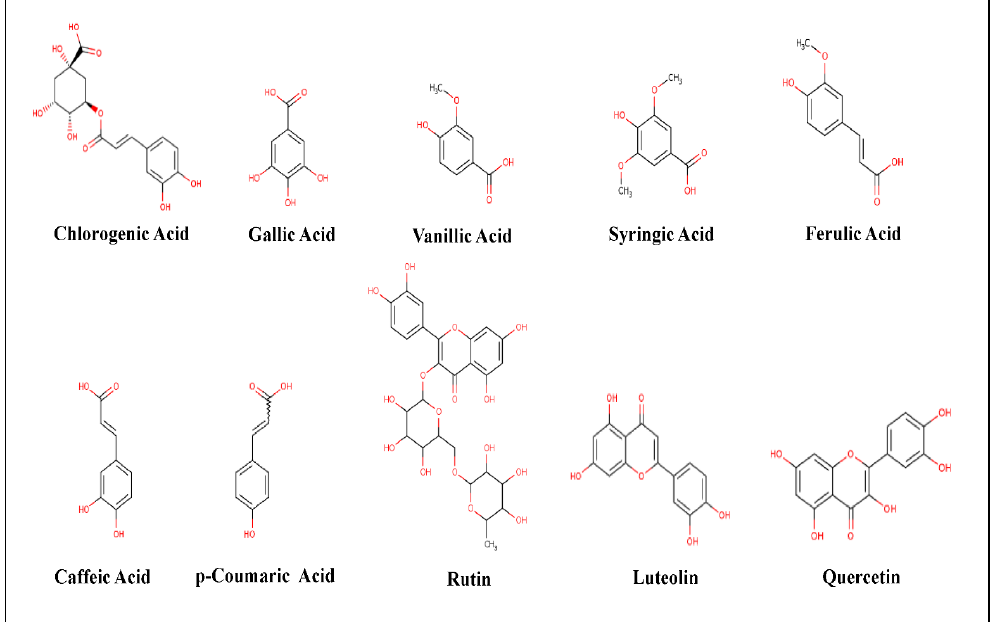
Figure 3. Chemical structures of the phenolic compounds resulted from GC/MS analysis. The chemical structures were created by MolView software (version 2.4) https://molview.org (accessed on 1 February 2020). Molecules 2022 , 27 , x FOR PEER REVIEW